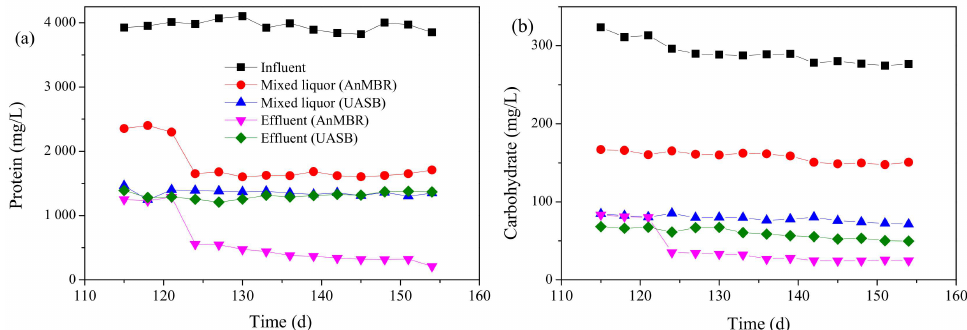
Figure 4. Variations of protein ( a ) and carbohydrate ( b ) in the studied AnMBR and UASB.